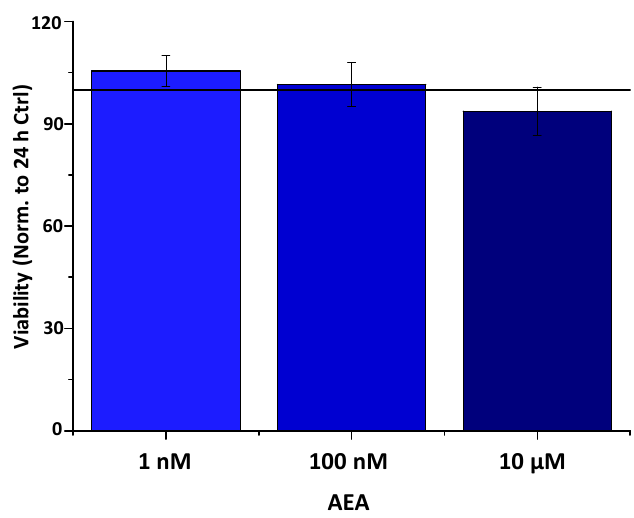
Figure A1. Time course of cytokine secretion after UVB irradiation from HCEC cells. ELISA determination of IL-6 and IL- 8 in the supernatant of human corneal epithelial cells following UVB irradiation at the marked time points. Data are ex- pressed as mean ± SD of three independent determinations. ***, **** mark significant ( p < 0.001, 0.0001, respectively) changes compared to the relevant time-matched control group.